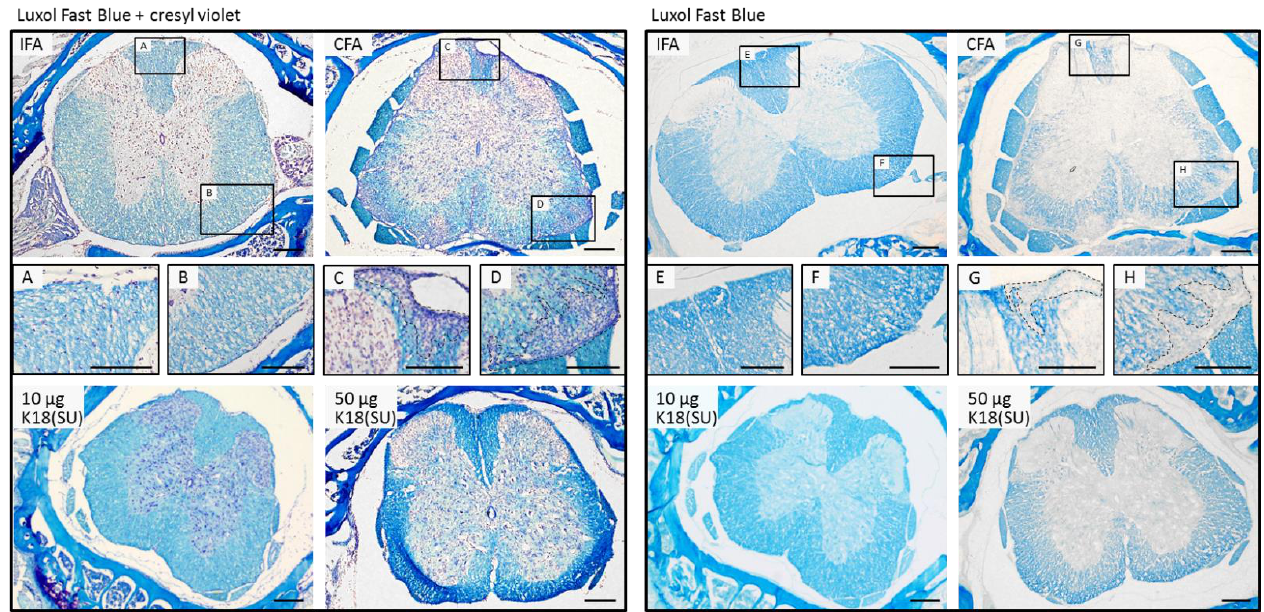
Figure 5. Luxol fast blue staining of representative cross-sections of the spinal cord of immunized mice for visualization of myelin sheaths. Treatment is indicated in the corner of each large image. Counter-stains with cresyl violet acetate shown in the left panel indicate staining of cell nuclei. ( A – H ) Magnifications of the areas labeled in the IFA and CFA sections to show intact white matter ( A , B , E , F ) and demyelinated areas ( C , D , G , H ) with putative infiltrated immune cells (( C , D , G , H ), dotted lines). Scale bar: 200 µ